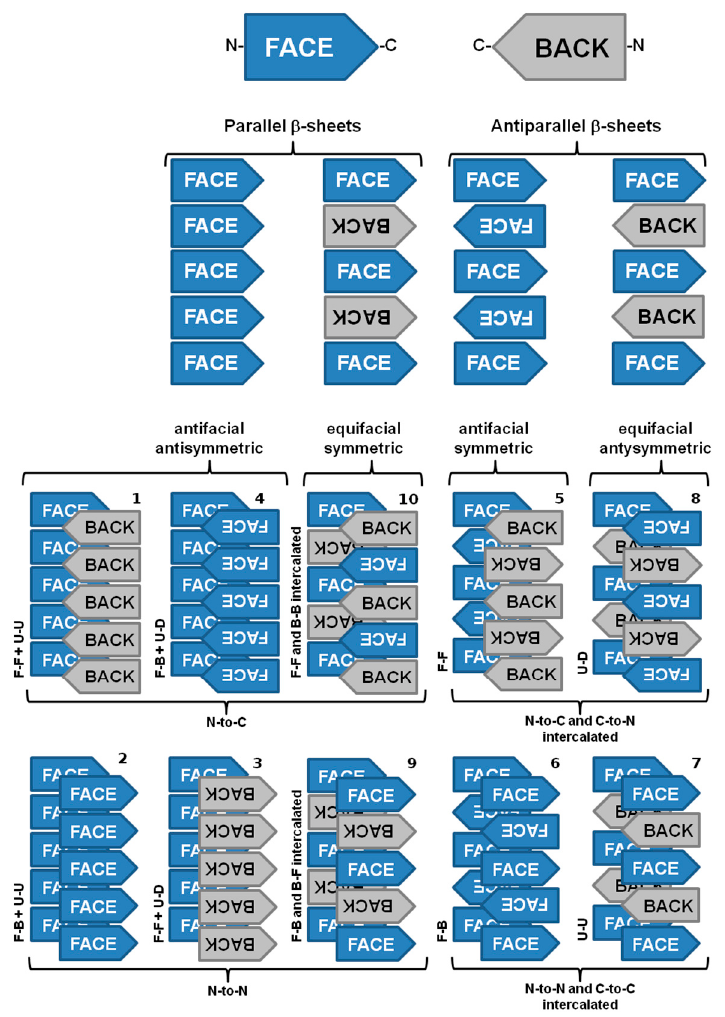
Figure 3. The ten possible amyloid symmetry classes of homo-steric zipper amyloid spines. Legend: face (F), back (B), up (U), down (D), N-terminal and C-terminal. Adapted from reference [65].